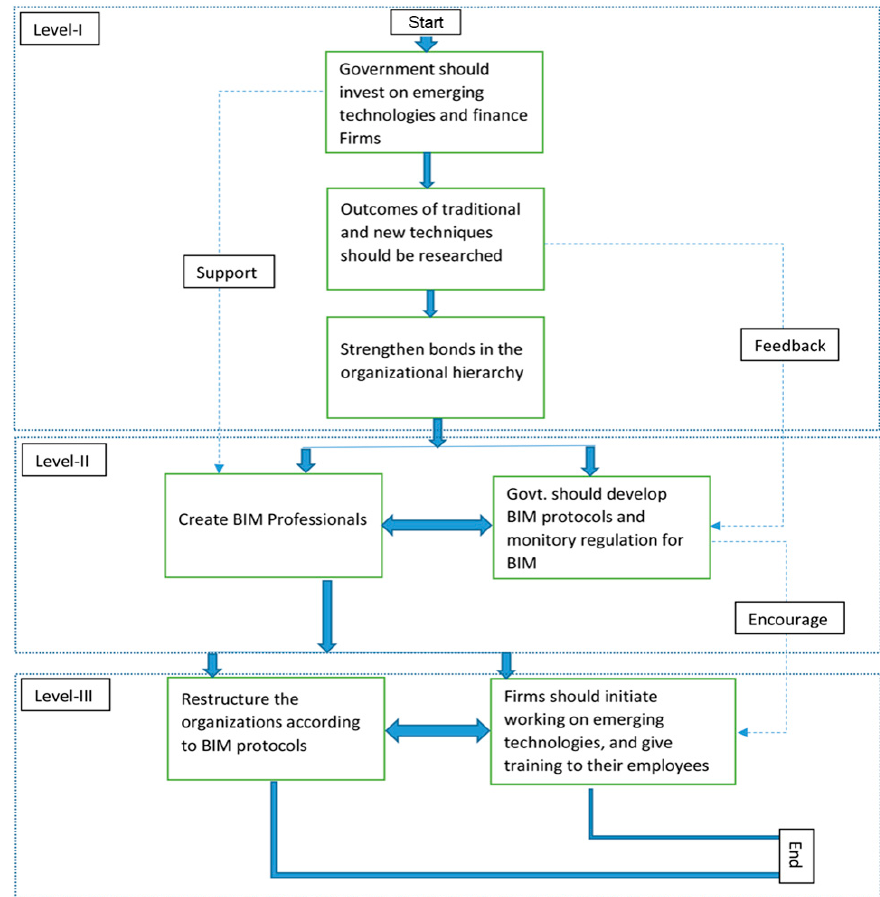
Figure 9. Developed strategy for different stakeholders.